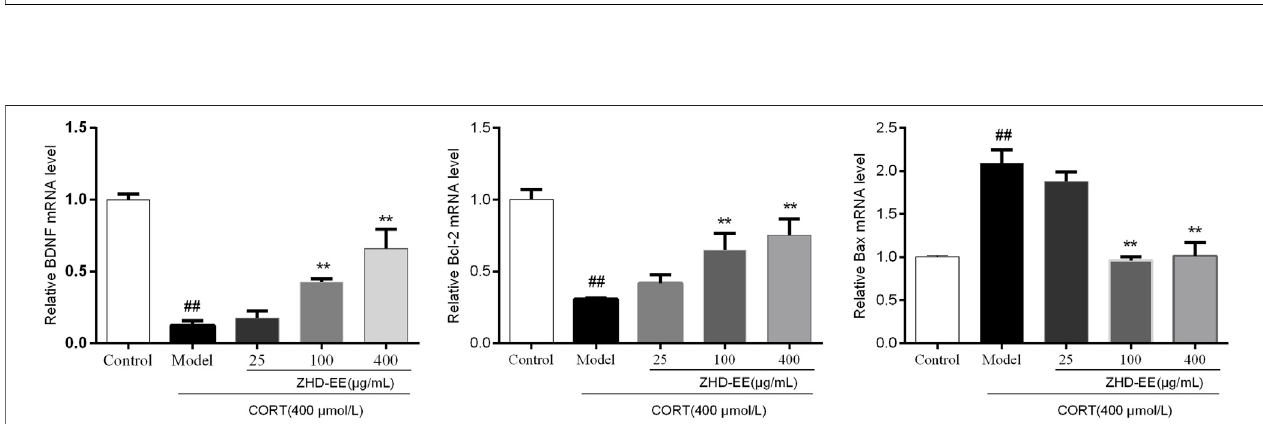
FIGURE 6 | Effect of ZHD-EE on the BDNF, Bcl-2 and Bax mRNA in CORT-treated PC12 cells. Data are expressed as a percentage of the control and the results are expressed as the mean ± SD ( n = 3). ## p < 0.01 compared with the control group, ** p < 0.01 compared with the CORT-treated group. ZHD-EE: ethanol extract of ZHD.